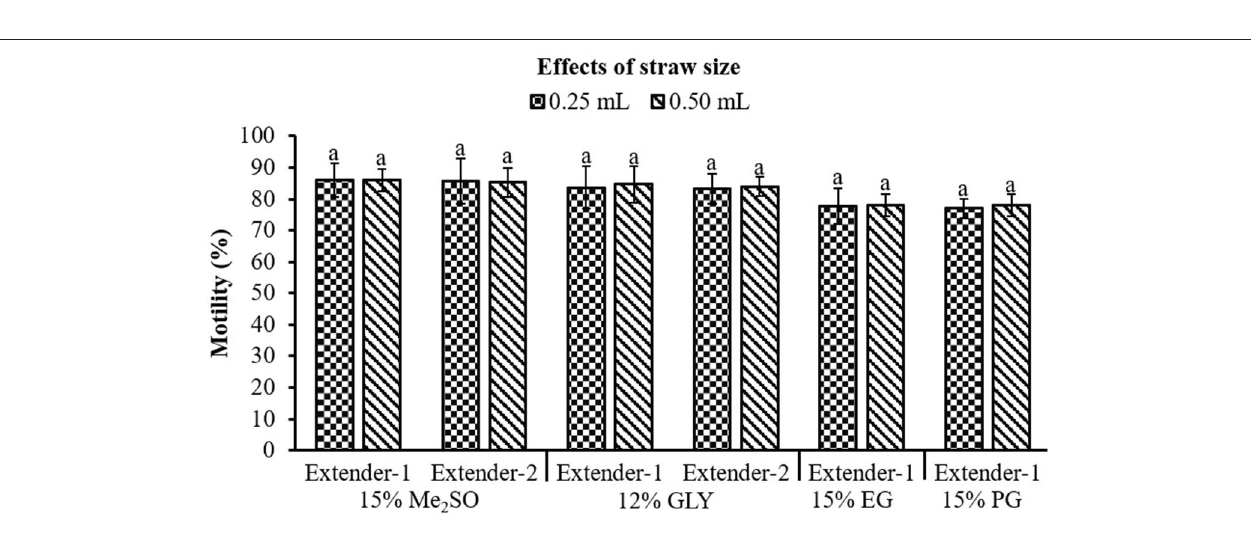
FIGURE 4 | Effects of straw size (0.25mL and 0.50mL) on post-thaw motility of marbled flounder sperm ( n = 3). Significant different levels ( p < 0.05) are denoted by different